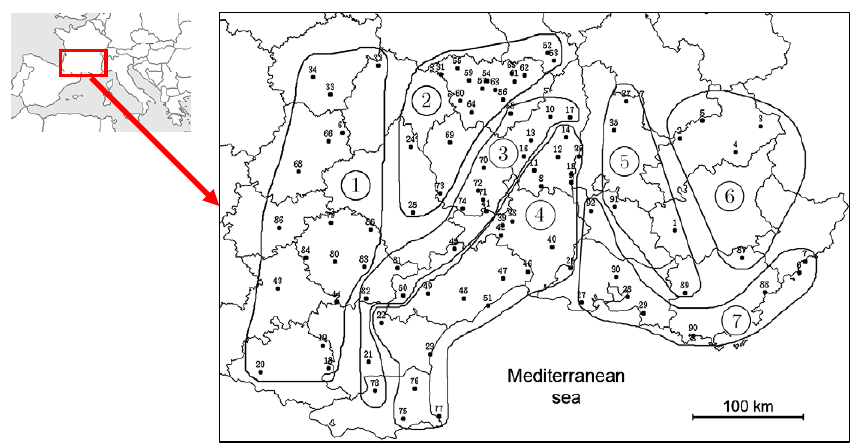
Figure 1: Study area with the seven homogeneous zones and the location of the 92 daily rain gauges.